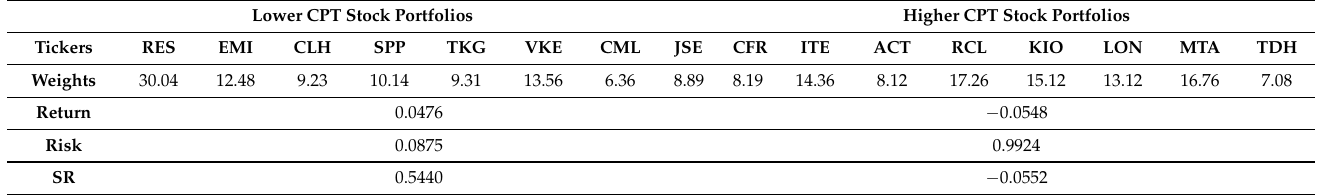
Table 4. Optimization results of JSE stock portfolios using BMV approach. Lower CPT Stock Portfolios